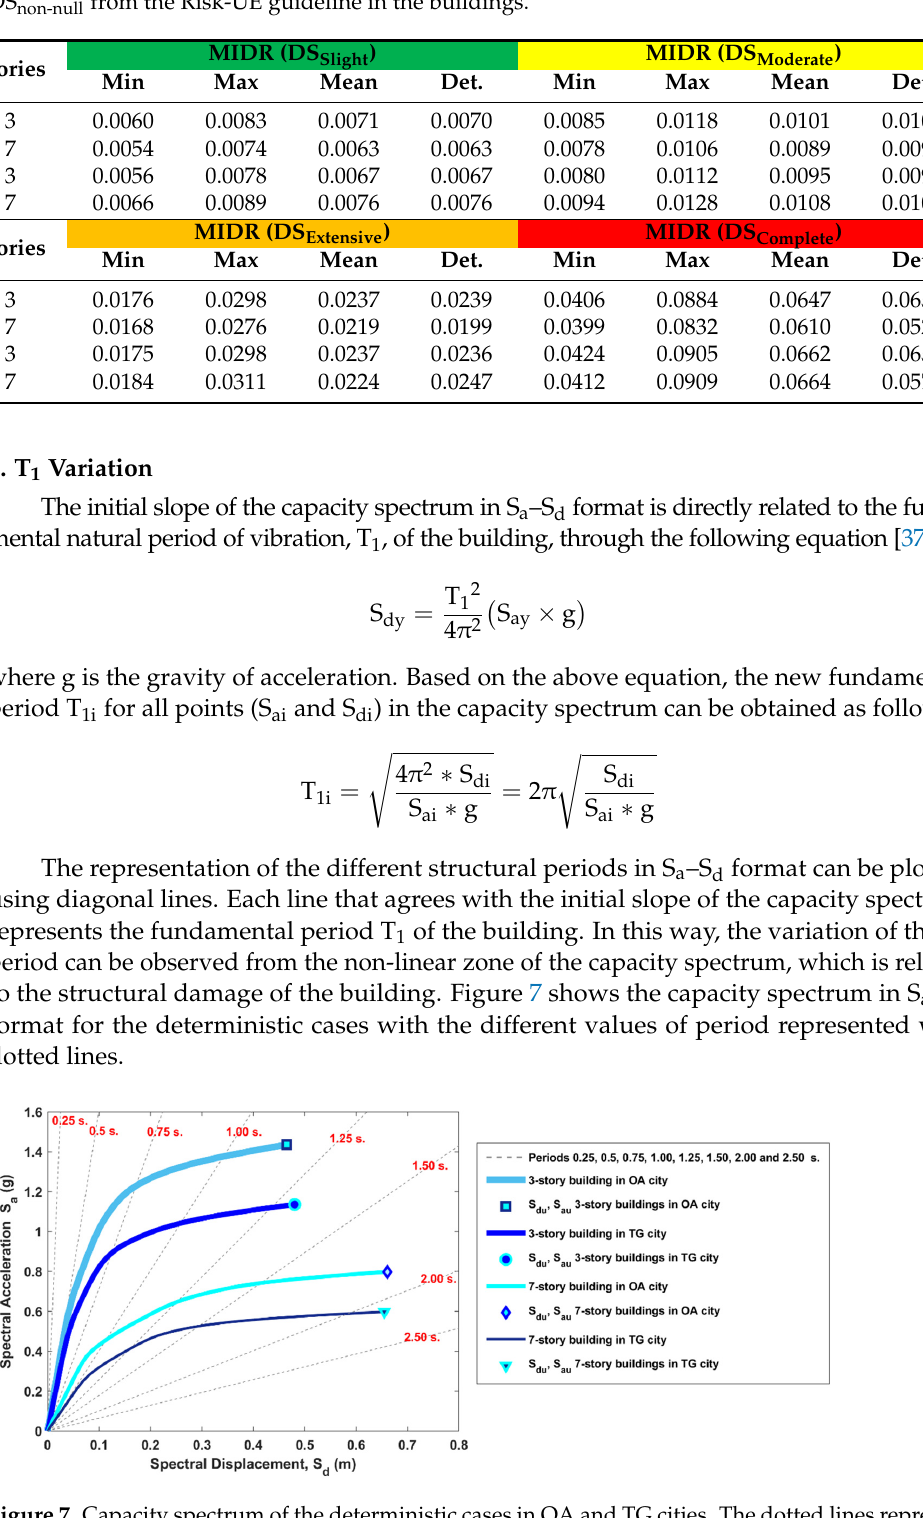
Figure 7. Capacity spectrum of the deterministic cases in OA and TG cities. The dotted lines represent different periods.